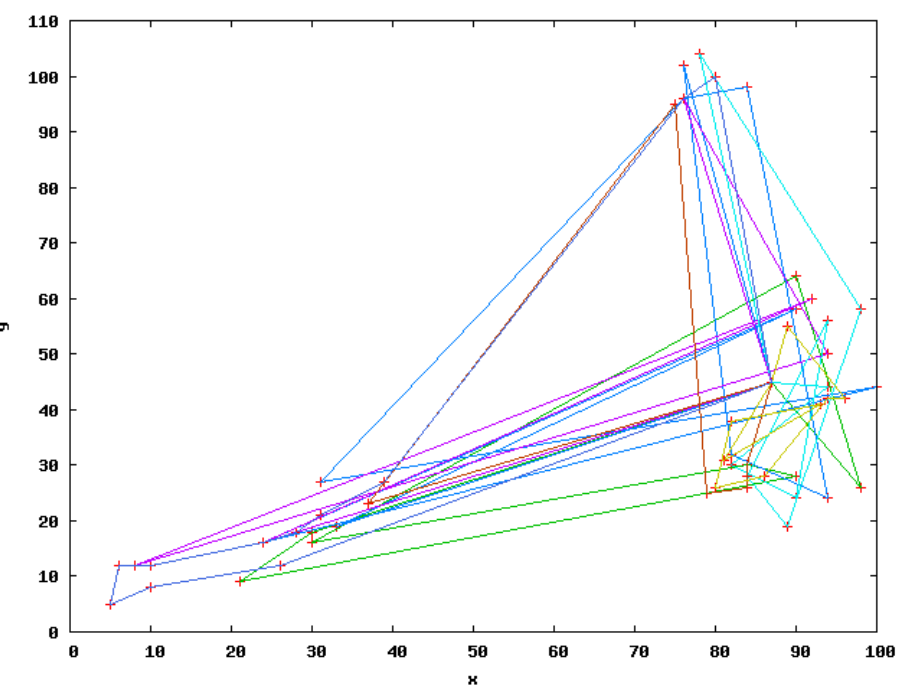
Figure 9. Crossover domination experiment—example from wrongly designed experiment, medium Augerat set P example, fitness distance from best-known one around a few